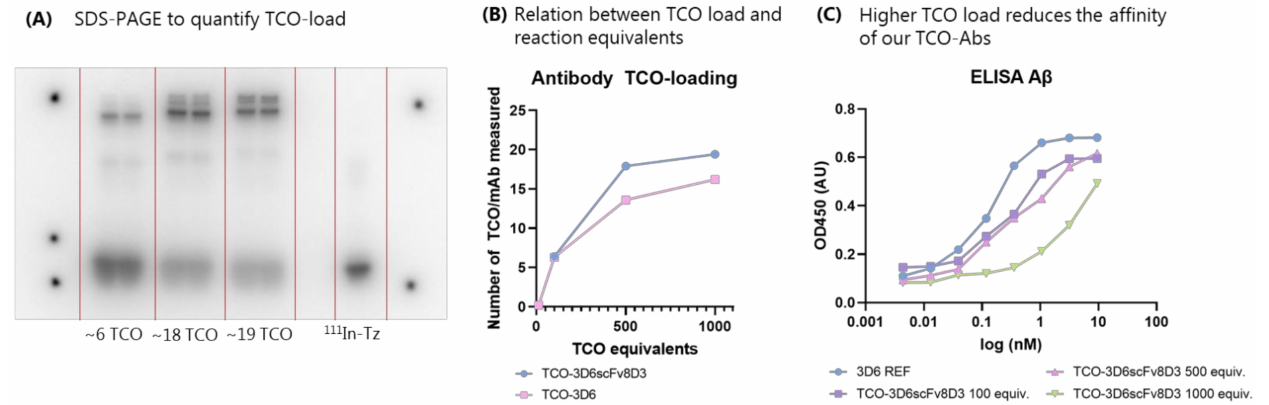
Figure 2. ( A ) SDS-PAGE with 111 In-Tz and TCO-Abs to quantify the TCO load. Activity at the bottom corresponds to the 111 In-Tz and the activity bands at the top to the radiolabeled Ab. The difference in radioactivity was used for the TCO quantification (Supplementary Materials). The lanes on the left correspond to ~6 TCO/Ab, and the middle lanes to ~18 and ~19 TCO/Ab TCO/Ab. The lane on the right is the 111 In-Tz without Ab (control). ( B ) Different TCO-loading can be reached using different equivalents of TCO. The saturation of TCO-loading was reached around 20 TCOs. ( C ) ELISA for A β with Ab 3D6 and TCO-3D6scFv8D3. Affinity was reduced with an increased amount of